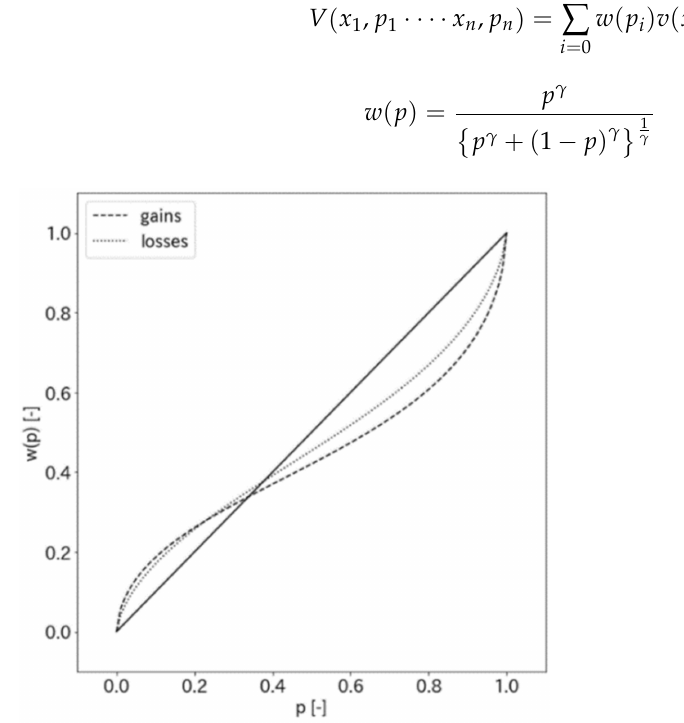
Figure A2. The Weighting Function (based on